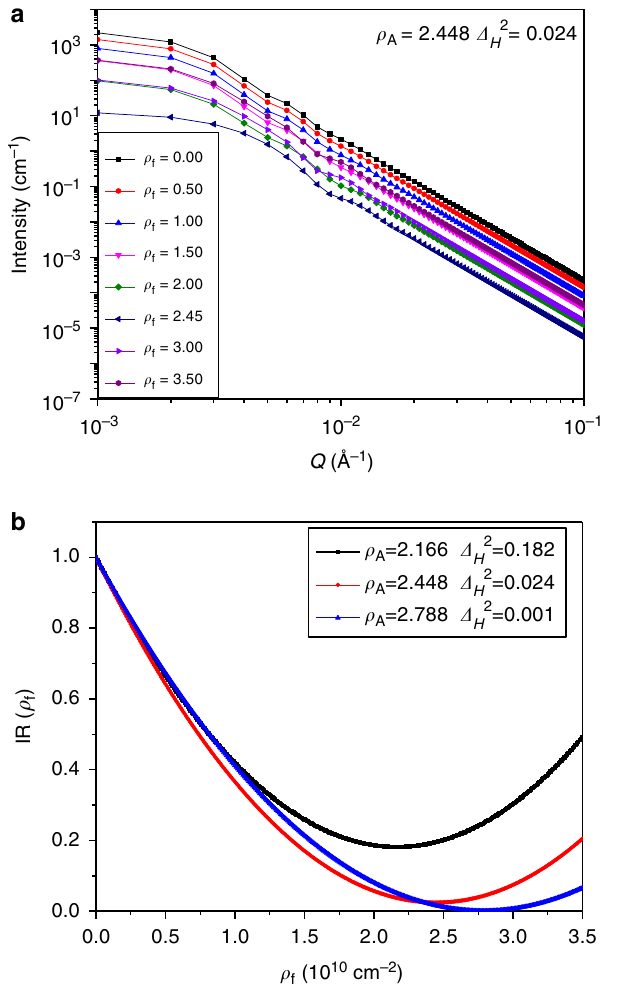
Fig. 2 Simulated scattering patterns of ideal model systems. a Simulation of scattering intensity I ( Q ) vs. Q for Model 2 ( ρ A = 2.448, Δ H 2 = 0.024) as a function of fl uid scattering length density (SLD), ρ f . b Intensity ratio, IR ( ρ f ) = I ( Q , ρ I ( Q , ρ = 0) = C ρ C ρ = 0), vs. ρ ρ = f )/ f GPS ( f )/ GPS ( f f for Model 1 ( A 2.166, Δ H 2 = 0.182), Model 2 ( ρ A = 2.448, Δ H 2 = 0.024), and Model 3 ( ρ A =